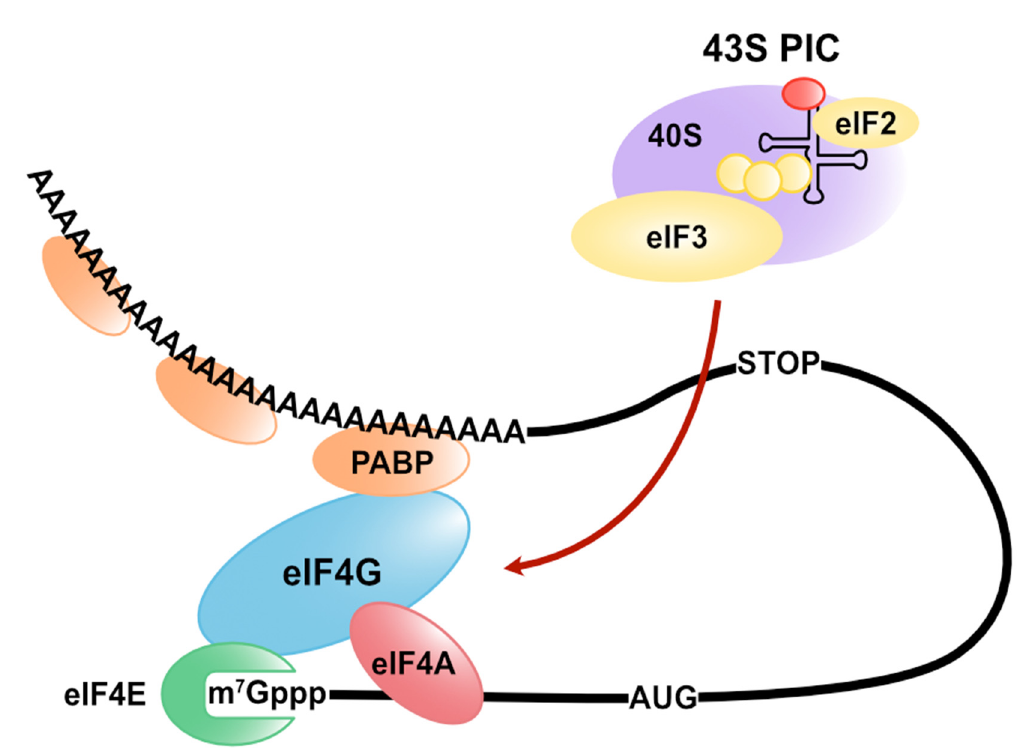
Figure 1. The formation of the basic translation initiation complex in eukaryotes. The eukaryotic translation initiation factor (eIF) 4F complex (which consists of eIF4E, eIF4G, and eIF4A) is assembled on the 5’ cap of mRNAs with PABP. The 43S PIC consists of 40S, a small ribosomal subunit, and several eIFs, such as eIF3 and eIF2.